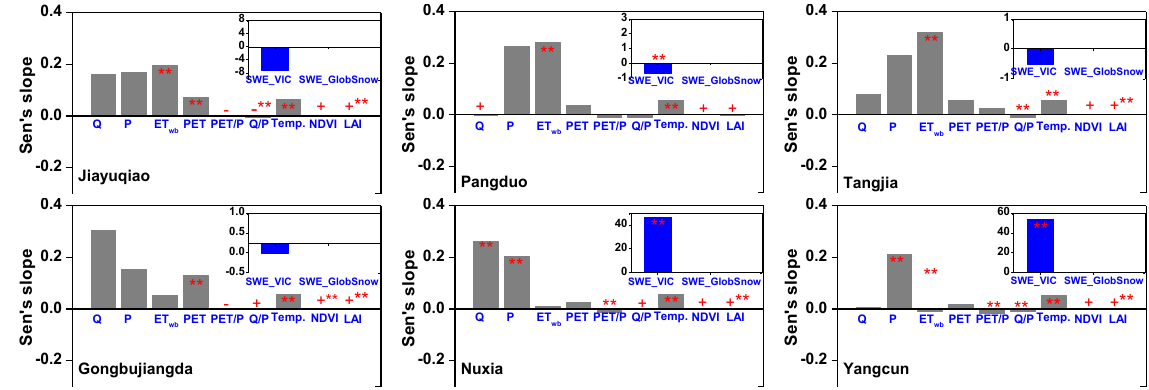
Figure 11. Similar to Fig. 8 but for Indian-monsoon-dominated TP basins. It should be noted that the GlobSnow data are not available for some basins. The double red stars showed that the trend was statistically significant at the 0.05 level. Table 4. Non-parametric trends for different ET estimates during the period 1982–2006, detected by modified Mann–Kendall test. The bold numbers show the detected trend is statistically significant at the 0.05